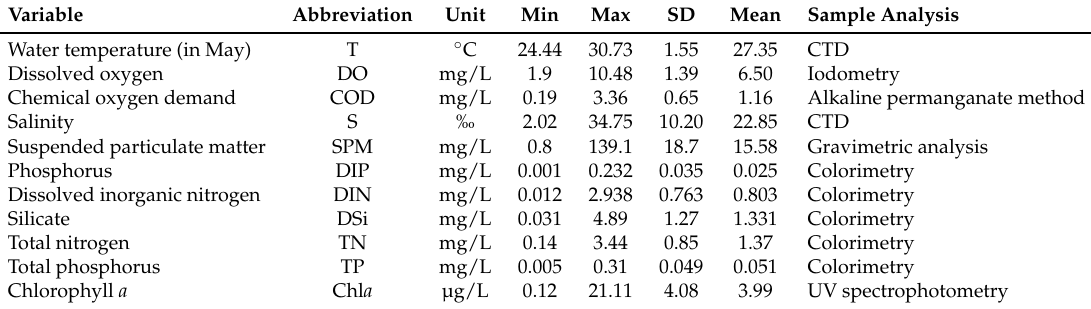
Table 1. Summary of water quality parameters in the Pearl River